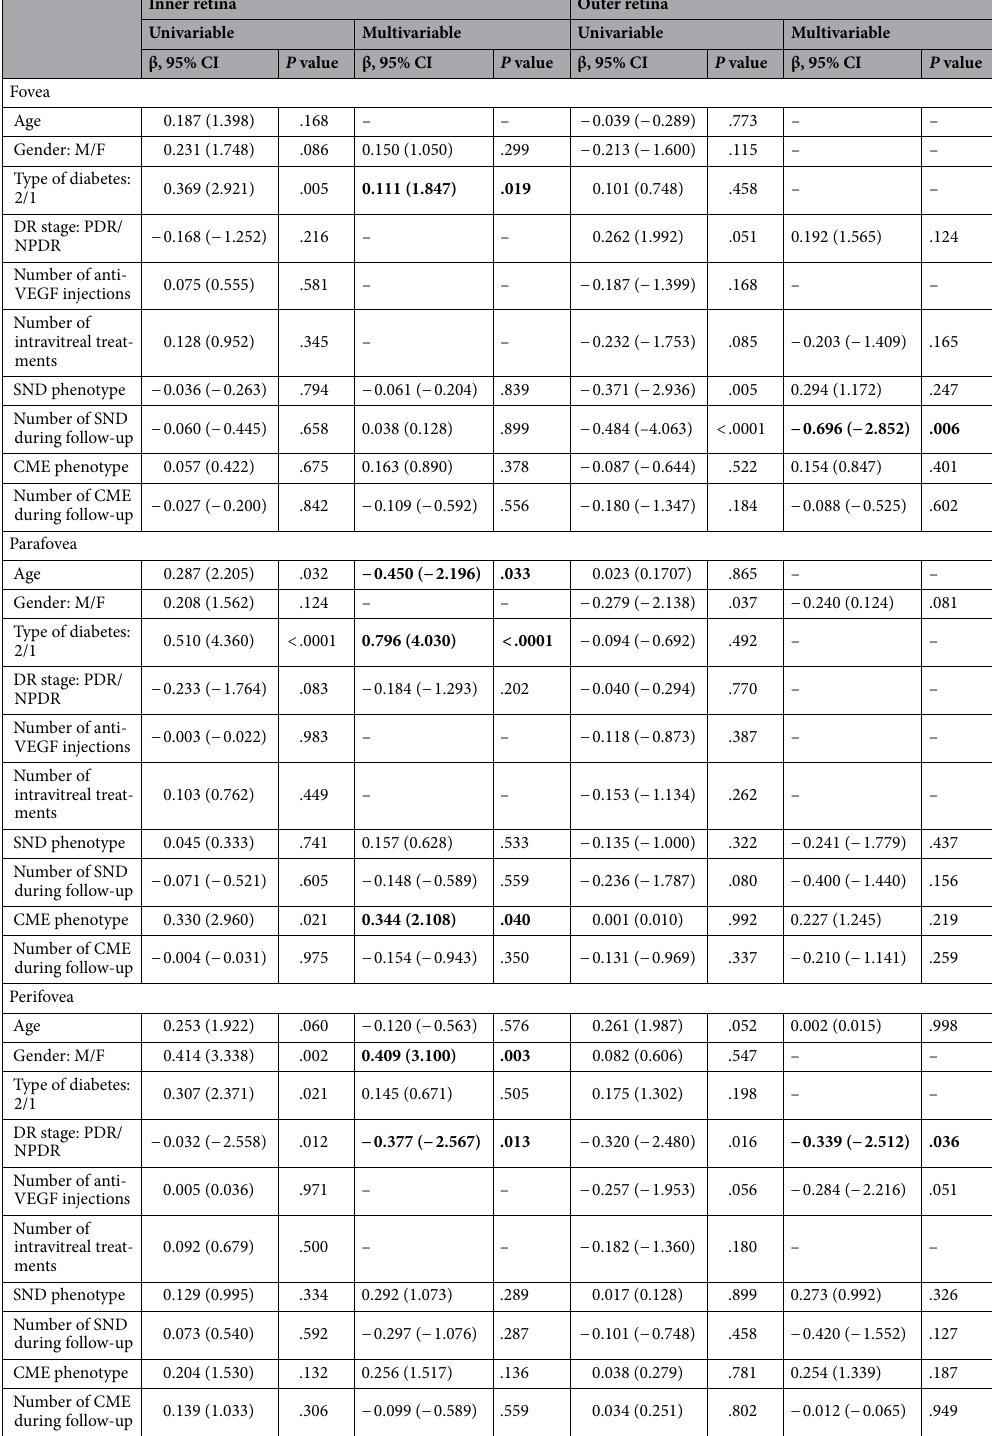
Table 1. Factors contributing to the rate of inner and outer retinal thinning by univariable and multivariable mixed model analysis. Values are shown in β coefficient (95% confidence interval), unless otherwise indicated. M males, F females, DR diabetic retinopathy, PDR proliferative diabetic retinopathy, NPDR non-proliferative diabetic retinopathy, VEGF vascular endothelial growth factor, SND subfoveal neuroretinal detachment, CME cystoid macular edema. Statistically significant p values shown in